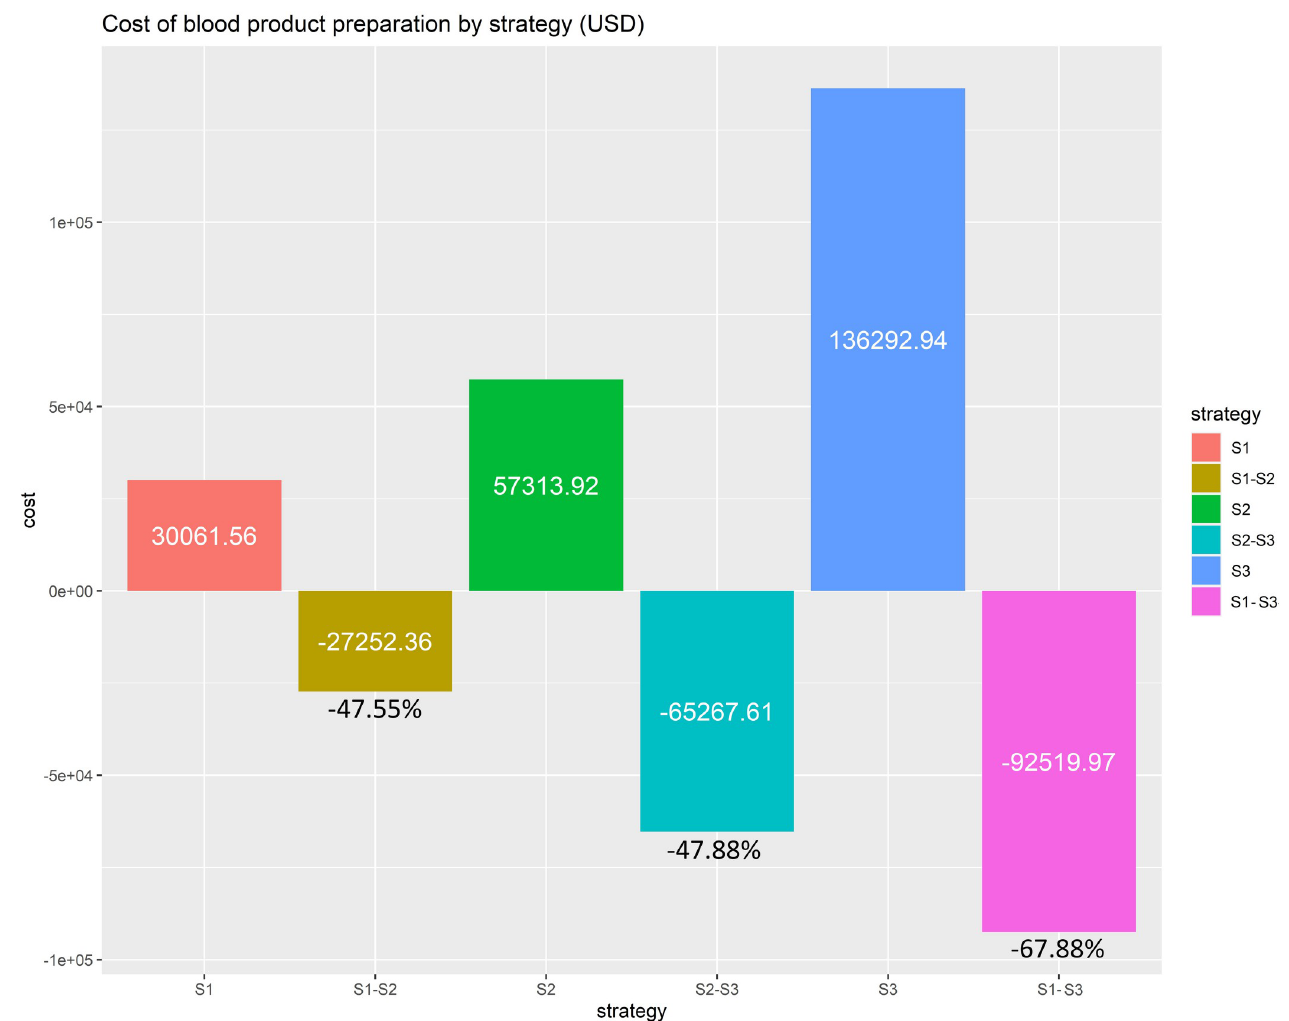
Fig 4. Cost and cost difference of preoperative blood product preparation among strategies. Abbreviations: S1 = Machine learning-based strategy, S2 = Clinical trial-based strategy, S3 = Routine-based strategy.